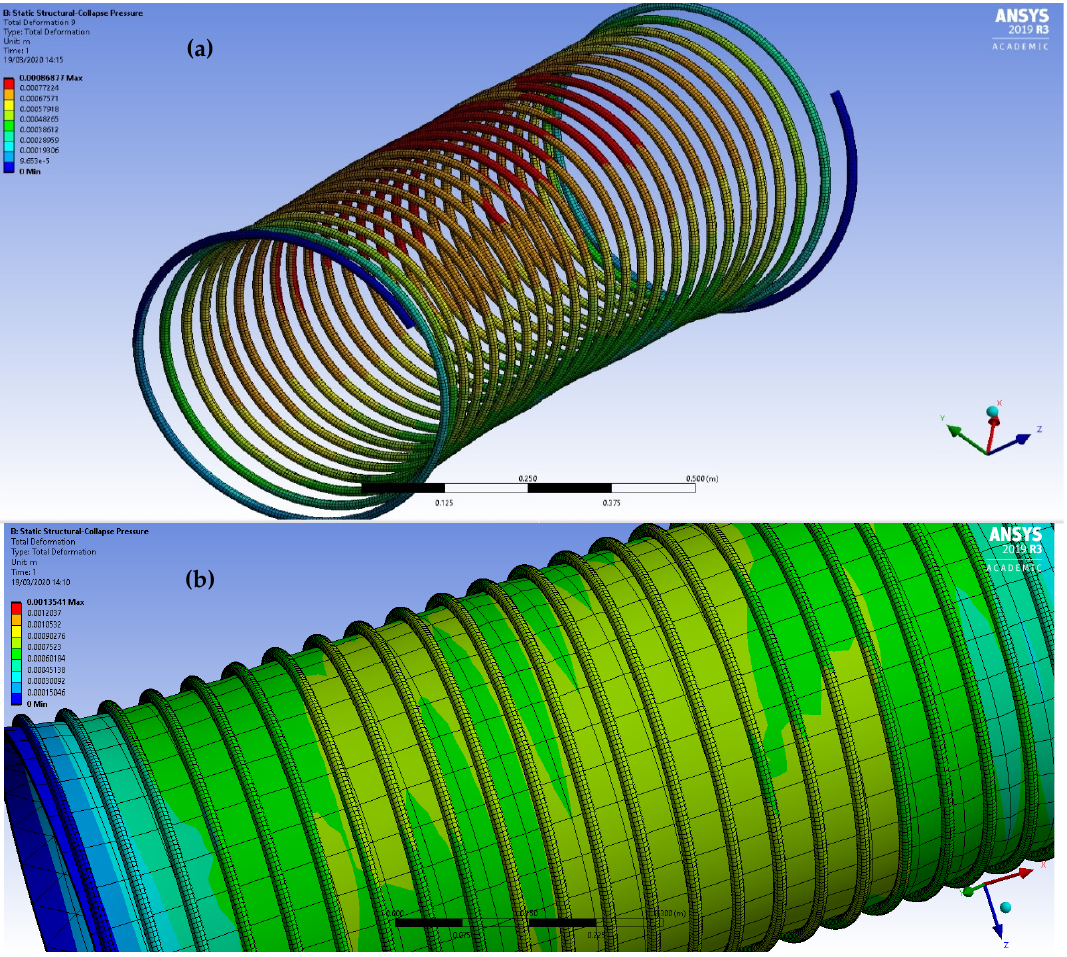
Figure 9. Reinforcement helix’s deformation during collapse test, showing ( a ) helix alone, and ( b ) helix on the underlying layer .